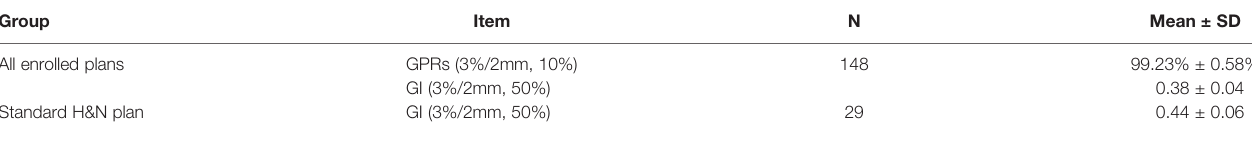
TABLE 1 | Summary of the descriptive statistics for QA